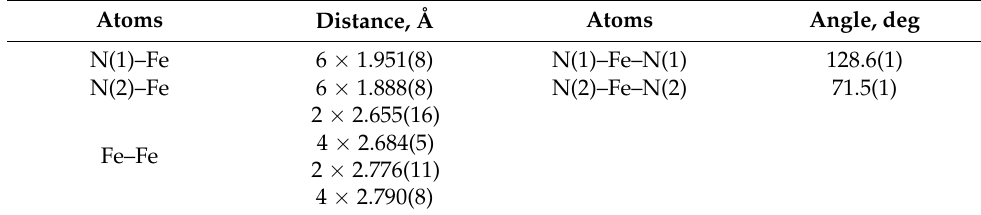
Table 8. Selected bond distances of siderazot in ambient